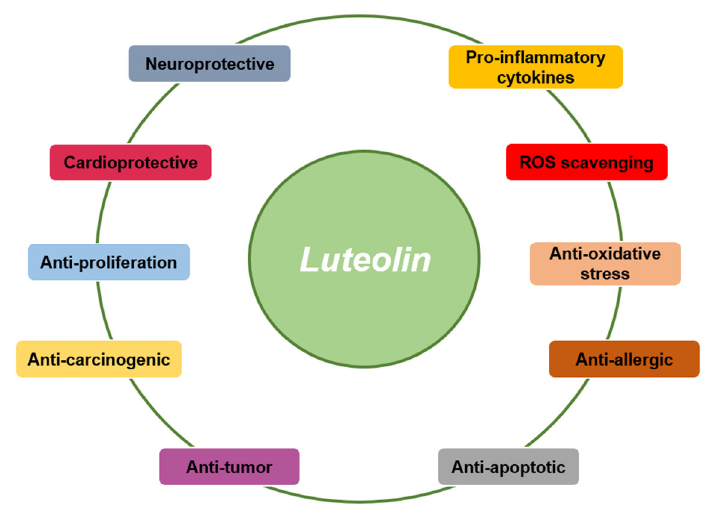
Figure 2. Various biological activities of luteolin. Various kinds of immunopharmacological activities of luteolin such as neuroprotective, cardioprotective, anti-oxidative, anti-allergic, and anti-tumor actions have been reported so far.